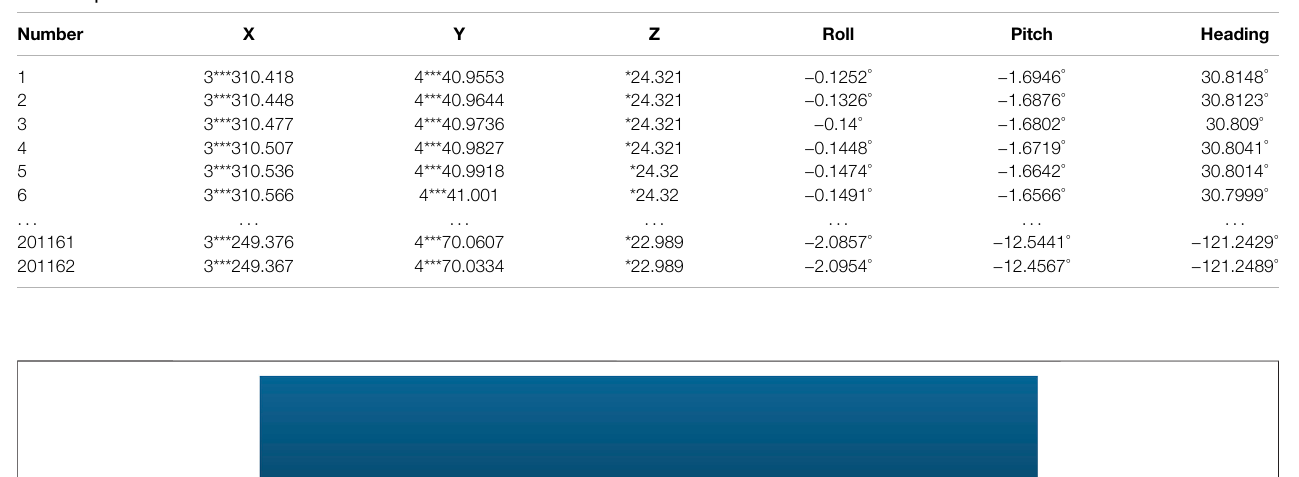
TABLE 2 | Coordinate information and attitude information.